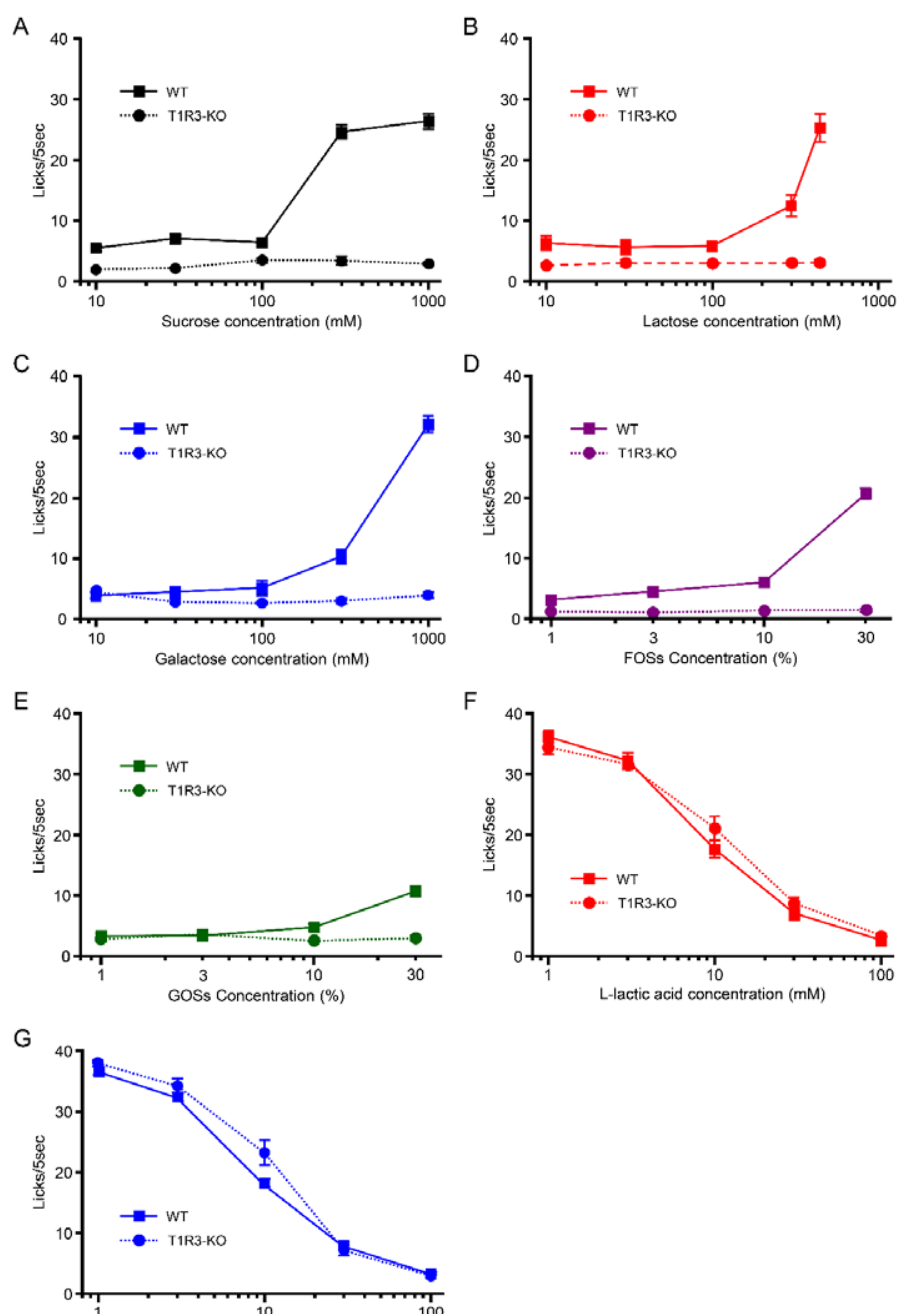
Figure 5. Comparison of short-term lick test between WT and T1R3-GFP-KO mice. ( A ) Sucrose. ( B ) Lactose. ( C ) Galactose. ( D ) FOSs. ( E ) GOSs. ( F ) L -lactic acids. ( G ) D -lactic acid. The WT mice ( n = 7). The T1R3-GFP-KO mice ( n = 8). All data are presented as the mean ± standard error. ANOVA results for these data are summarized in Table 1.